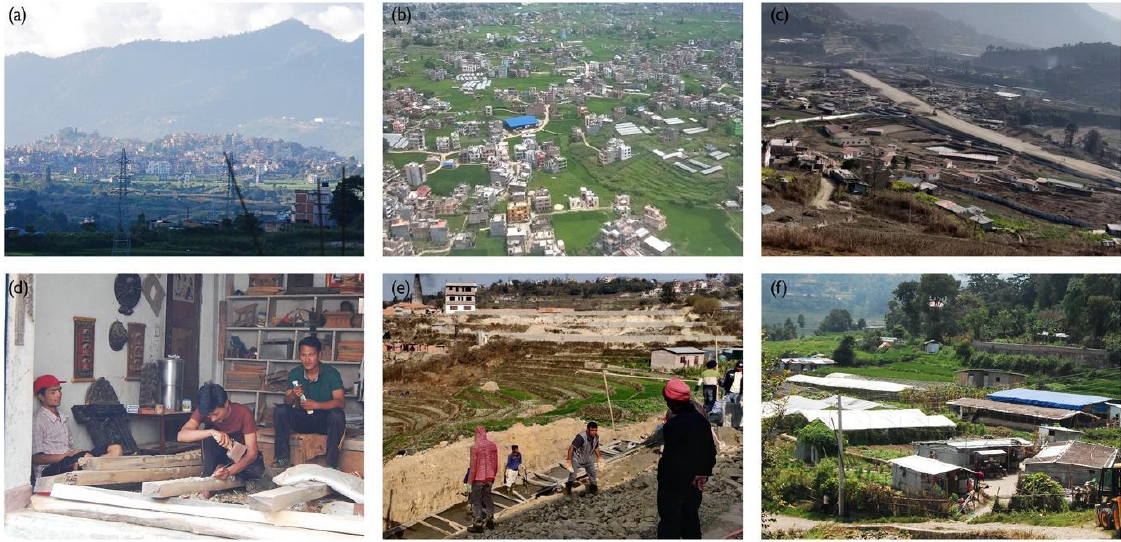
Figure 1. The vignettes from Kathmandu's landscape; (a) Kirtipur village highlights the traditional logic of occupying higher plateaus for settlements and valley for agriculture; (b) Haphazard urbanisation is consuming the productive farmlands; (c) New mobility infrastructure and brick manufacturing in Bagmati valley; (d) Farmer-craftsmen, engaged in crafts between the planting and harvesting; (e) construction of new road infrastructure gradually consumes the terraced landscape; (f) Small vegetable lots utilising household wastewater provide much-needed employment opportunities to peripheral communities during the post-earthquake rehabilitation. Source: